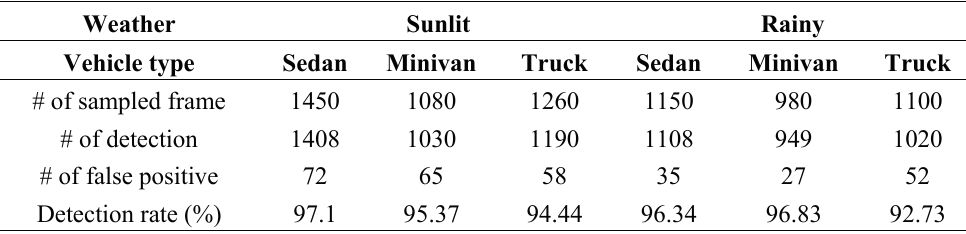
Table 4. Detection results on the public